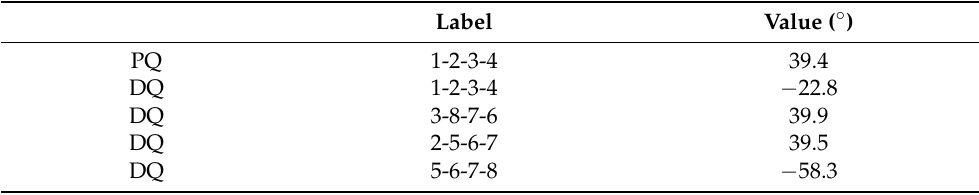
Table 1. Values of some dihedral angles for paraquat (PQ) and diquat (DQ) molecular structure according to density functional theory (DFT) calculations.